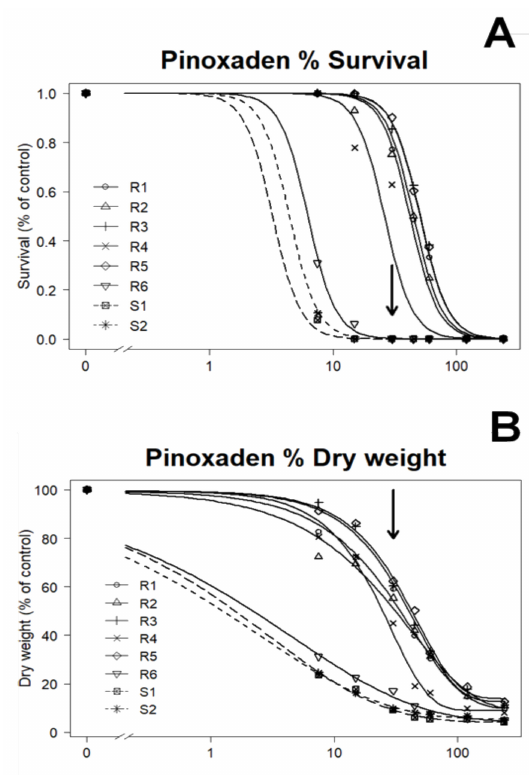
Figure 2. Dose-response curves for survival ( A ) and shoot dry weight ( B ) of susceptible (S) and test populations (R1 to R6) of A. fatua treated with a range of dose rates covering from 0.25 × to 8 × recommended field rate of pinoxaden. Arrows indicate the recommended field rate of 30 g pinoxaden ha − 1 for A. fatua